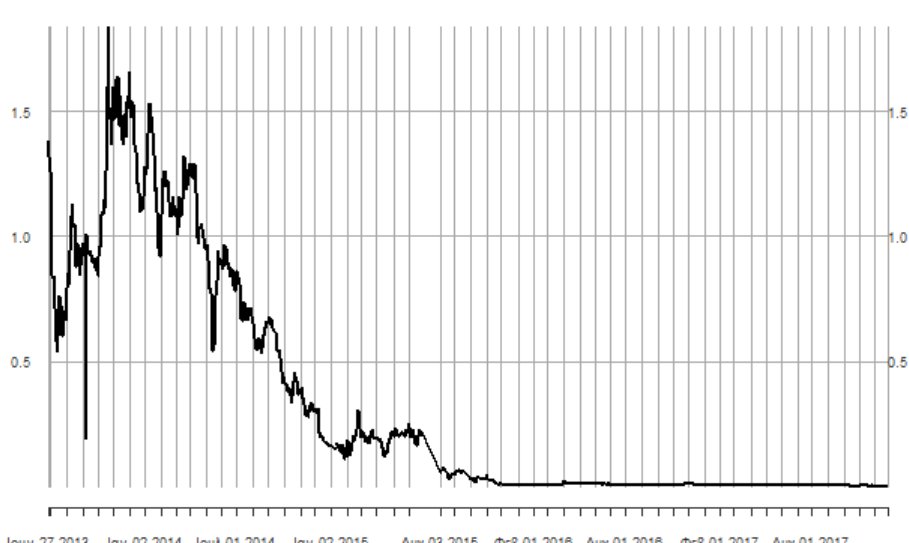
Figure 1. NBG warrants-clossing prices